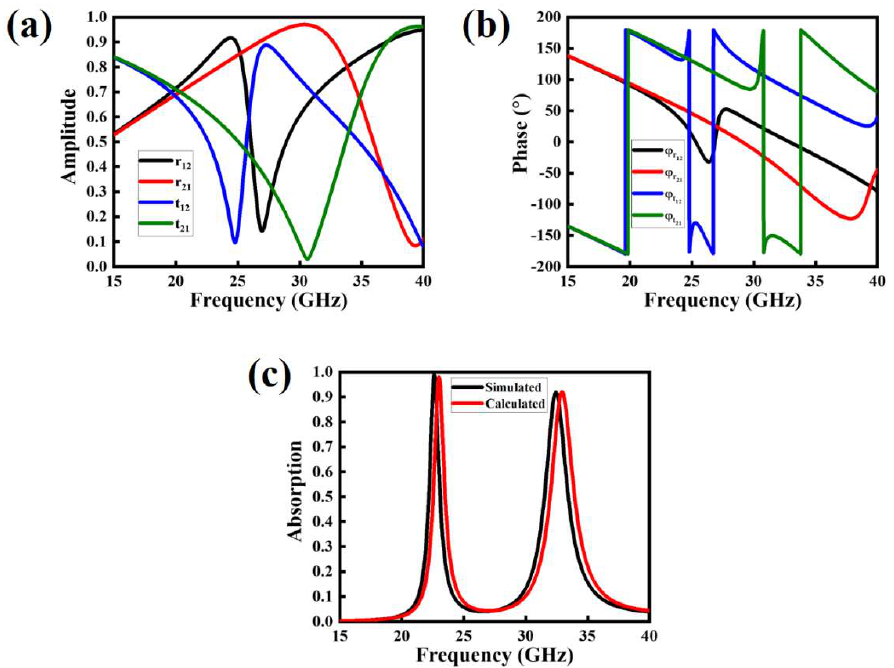
Figure 7. Estimated results of the proposed MMA through multiple-reflection-based interference theory model, ( a ) amplitude of the reflected and transmitted waves inside the cavity model, ( b ) phase of the reflected and transmitted waves inside the cavity model, and ( c ) comparative analysis of simulated and calculated absorption .